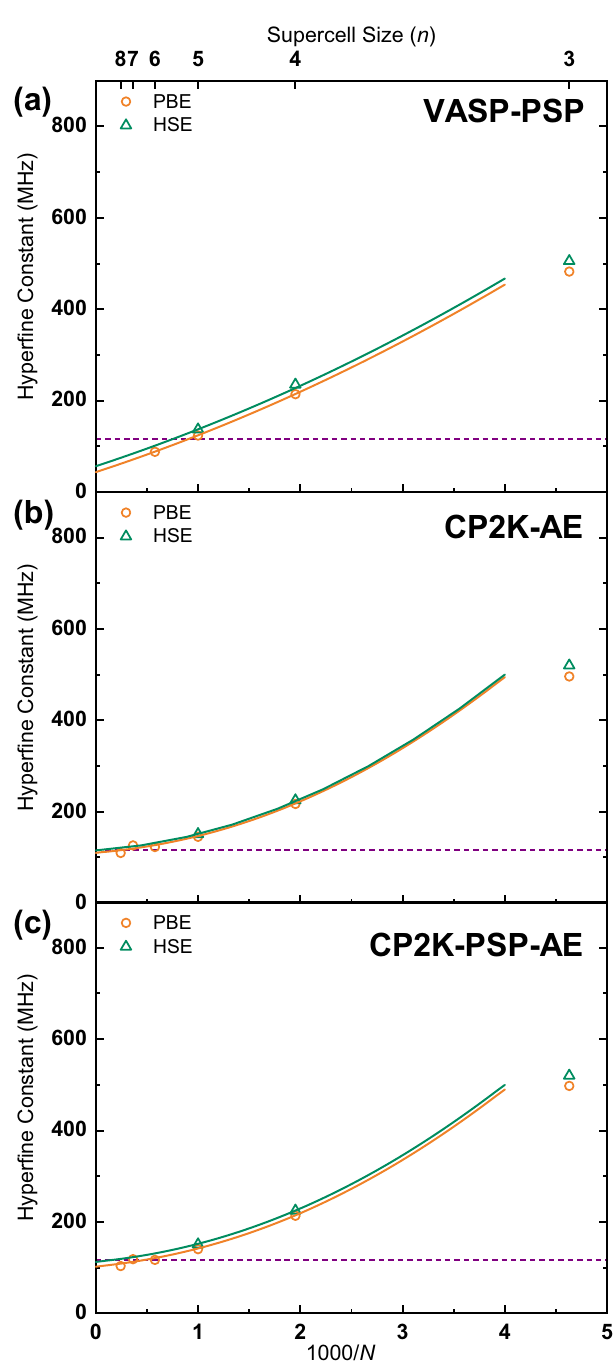
Fig. 2 Fermi contact hyper fi ne parameters. Fitting the hyper fi ne constants calculated from Perdew – Burke – Ernzerhof (PBE) and Heyd, Scuseria, and Ernzerhof (HSE) functionals as a function of the supercell size ( N ) and extrapolating N (cid:2)!1 to obtain the intercept value using different approaches: a Pseudopotential approximation approach (VASP-PSP), b All-electron approach (CP2K-AE), and ( c ) Pseudopotential approximation and all-electron mixed approach (CP2K-PSP-AE); dashed line represents the experimental